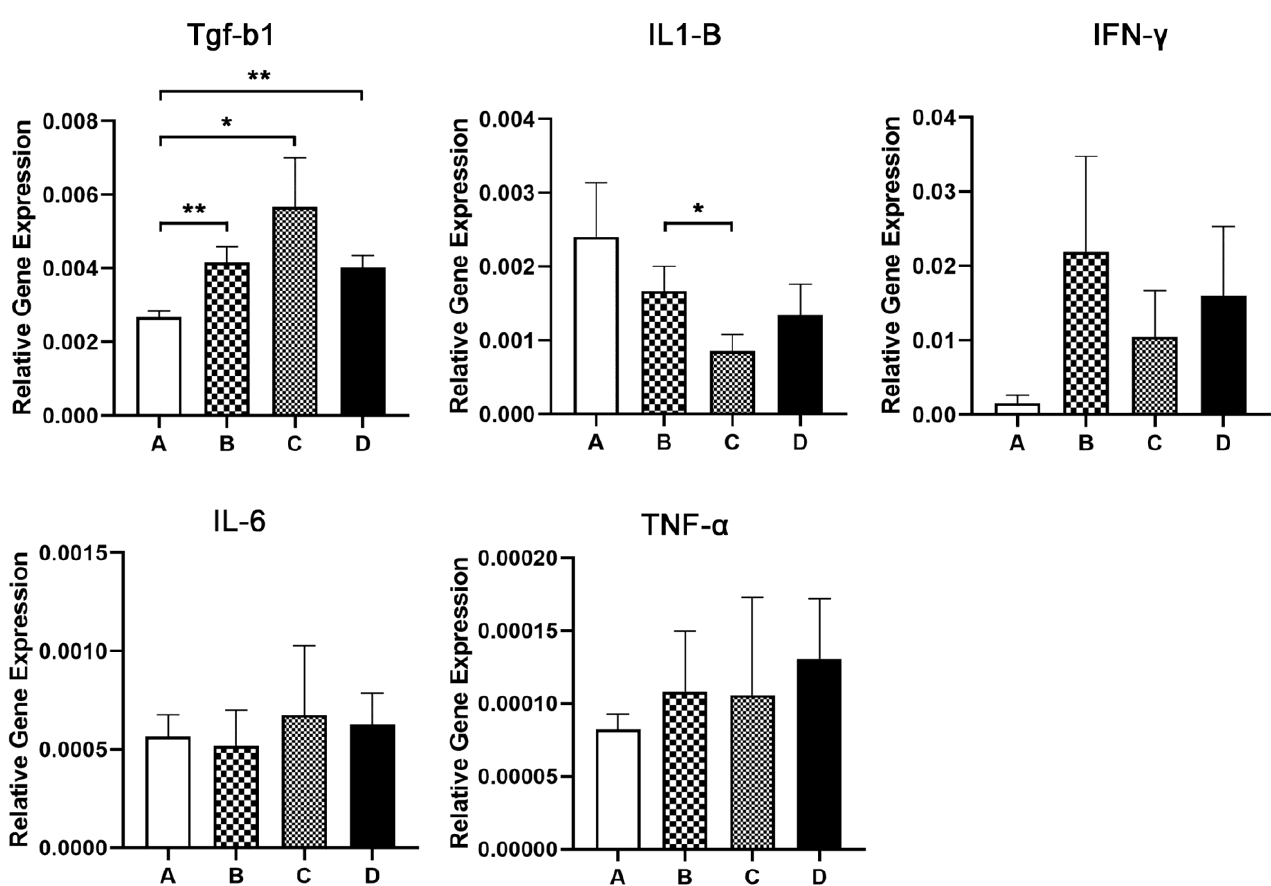
Figure 7. Expression of Tgf- β, IL1- β, IFN - γ, IL -6 and TNF- α in the colonic mucosa of the four experimental groups.* p < 0.05, ** p < 0.01. Letters of the x- axes correspond to the experimental groups (A, B, C, D).